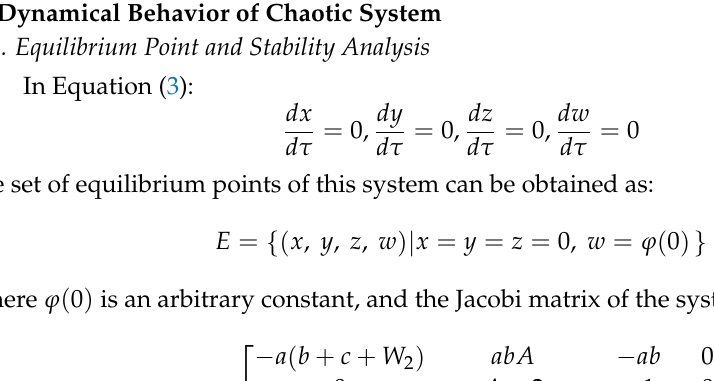
Figure 5. Dynamic behavior of circuit system with τ : ( a ) Lyapunov exponents spectrum; ( b ) time domain